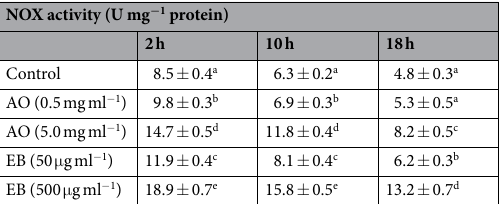
Table 1. Effects of mutagens on NOX activity in different coloured maize seeds. Effects of different concentrations of AO and EB on the NOX activity of white maize seeds. Means followed by the same letter are not significantly different ( p < 0.05) among different treatments. For each treatment, five replicates were analysed. EB, ethidium bromide; AO, acridine orange; NOX, NADPH